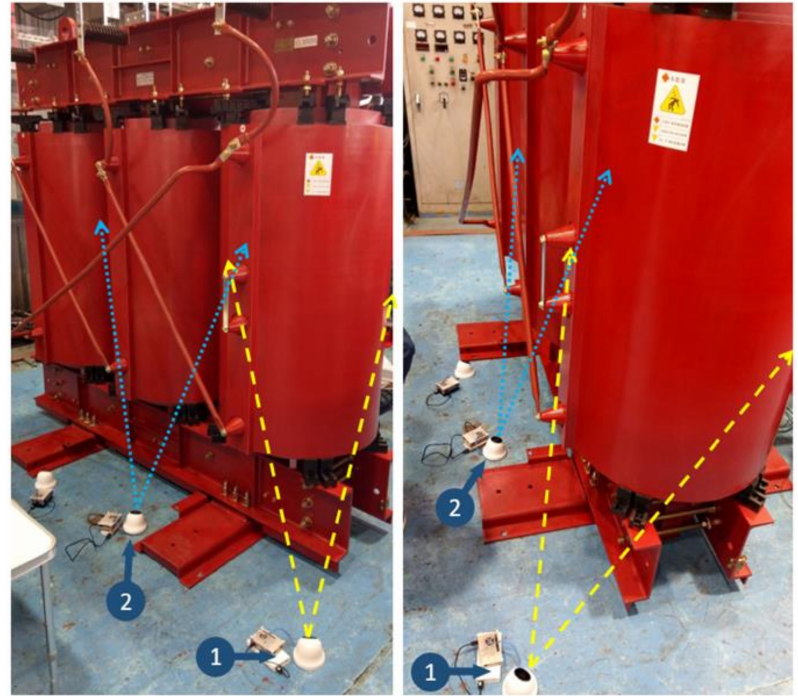
Figure 6. The experimental environment with sensors 1 & 2.